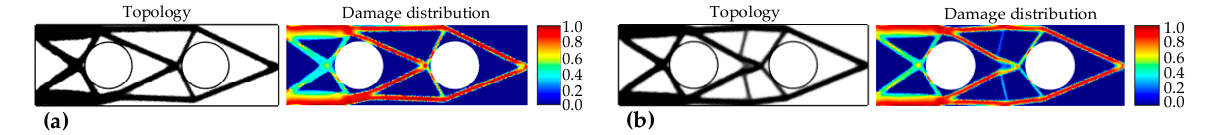
Figure 16. Optimal topology and damage distribution for a rectangular plate with circular holes: ( a ) P-norm constraint ( f = 0.407), ( b ) local constraint ( f = 0.374).